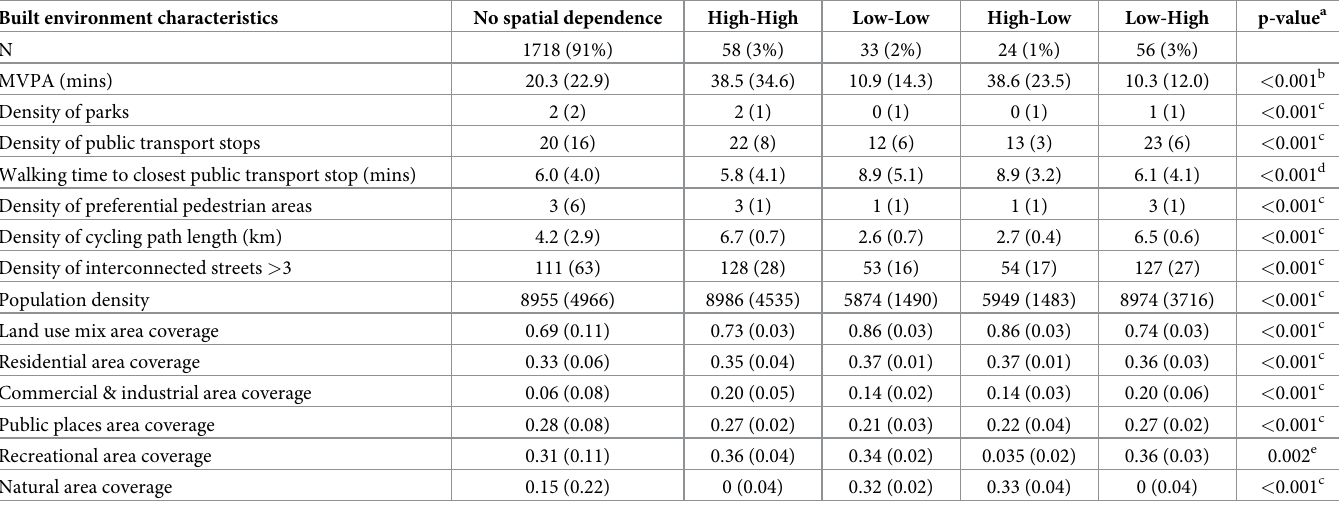
Table 2. Built environment characteristics in spatial clusters of MVPA adjusted for socioeconomic and demographic